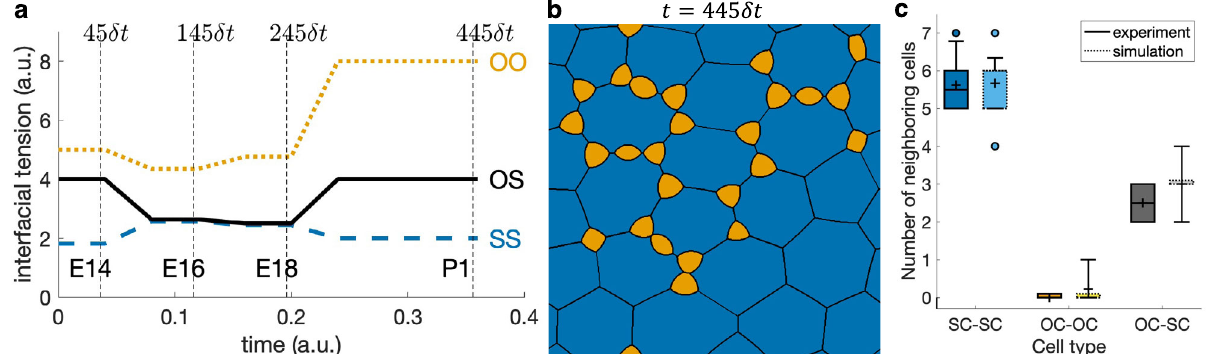
Fig. 4 Simulation of developing olfactory epithelium until postnatal stage. a Evolution of interfacial tensions at OO (orange dotted line), OS (solid black line), and SS (blue dashed line) junctions based on measurements up to embryonic stage E18 but is selected hypothetically for postnatal stage P1 (Supplementary Data 3). b Pattern obtained at the fi nal time 445 δ t , showing round separate olfactory cells (orange) and supporting cells (blue) arranged in a pattern similar to experimental image in Fig. 3a (P1). Patterns obtained at earlier times until 245 δ t are identical to those in Fig. 3c. c Boxplot of neighboring cell counts corresponding to this hypothetical simulation. Counts for the simulation image ( b ) are shown on the right in light colors. The meaning of the boxes and markers is the same as in Fig.